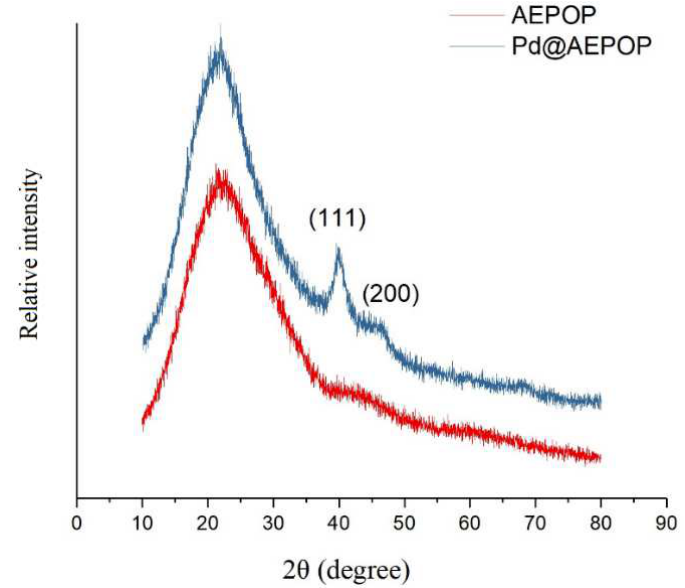
Figure 3. PXRD patterns of AEPOP and Pd@AEPOP.